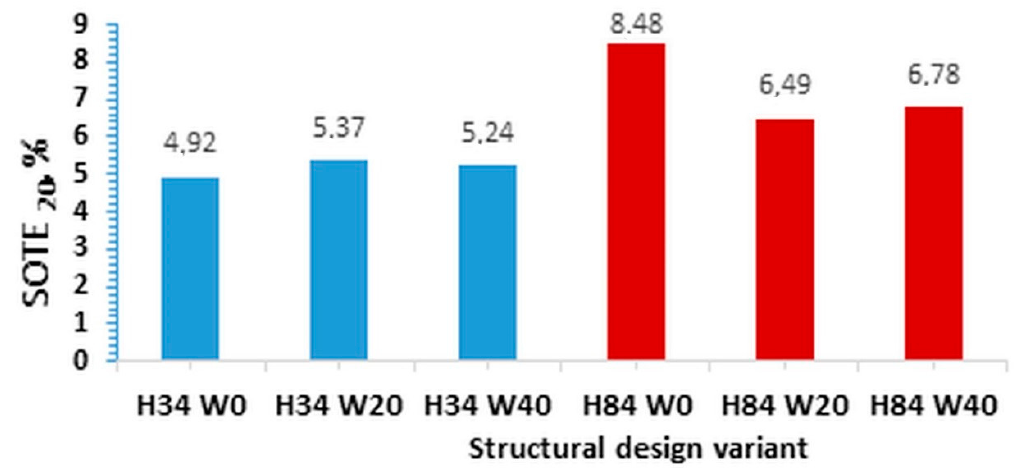
Figure 13. Standard oxygen transfer efficiency (SOTE) in the tested barbotage reactor.